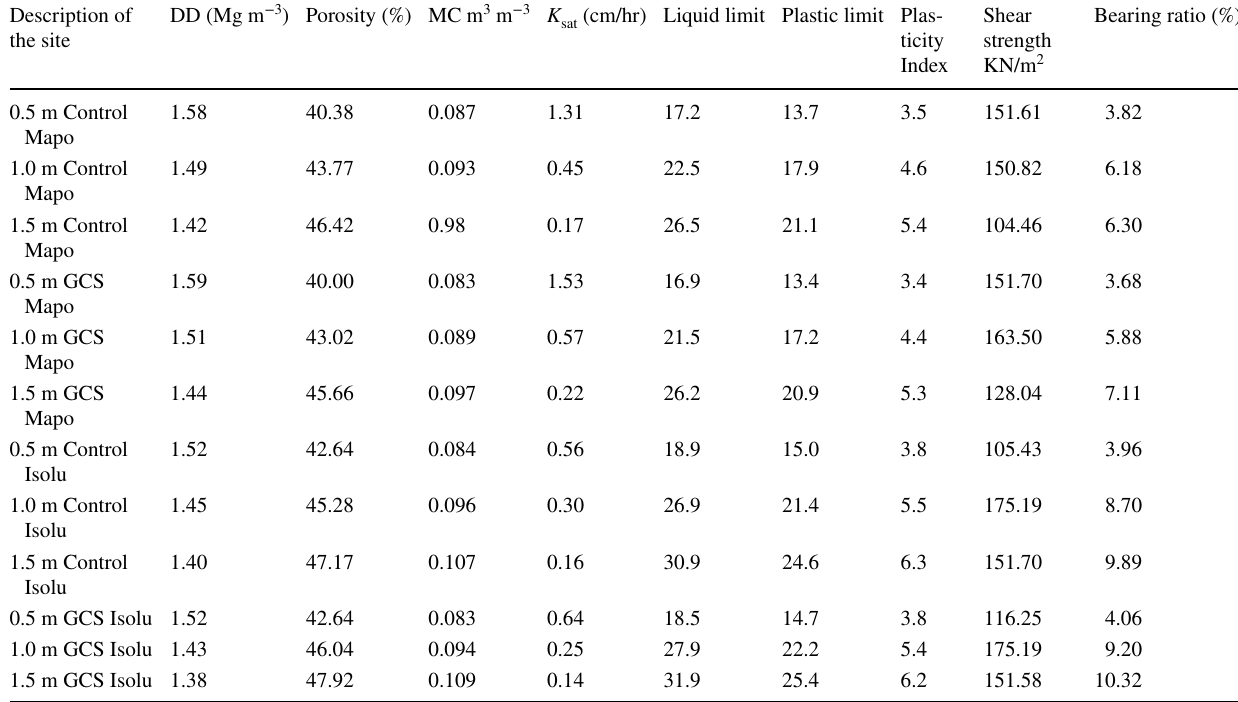
Table 2 Results of geotechnical and hydraulic properties of analysed samples Description of the